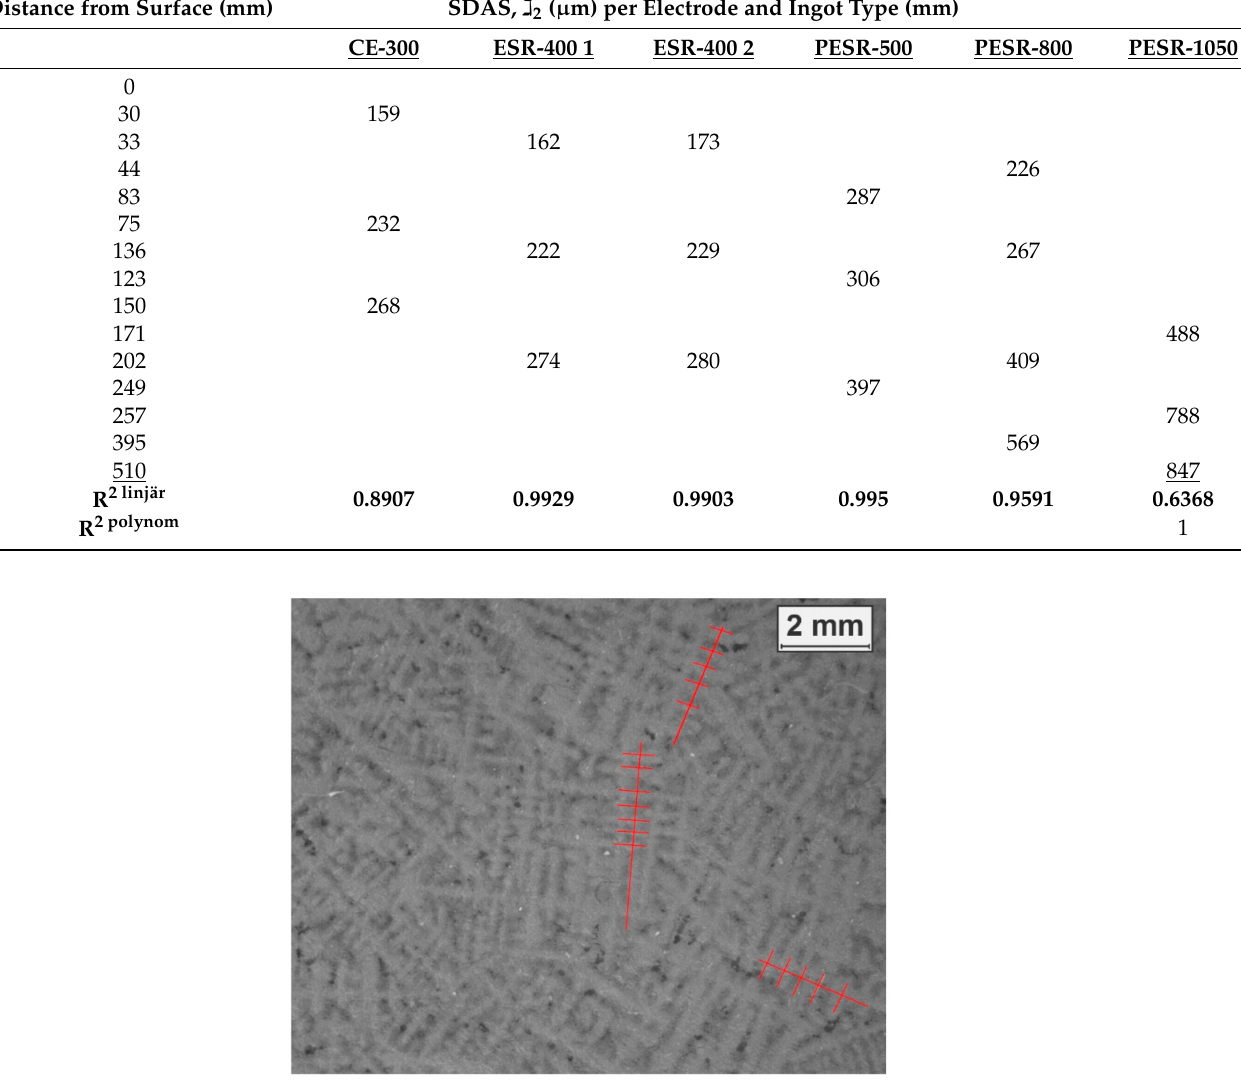
Figure 5. Measure principle, example from position T/2 (center) of the 500 mm in diameter in- got (PESR-500). The primary arms and their connecting secondary arms are marked in red. The measurement was made in-between the red secondary